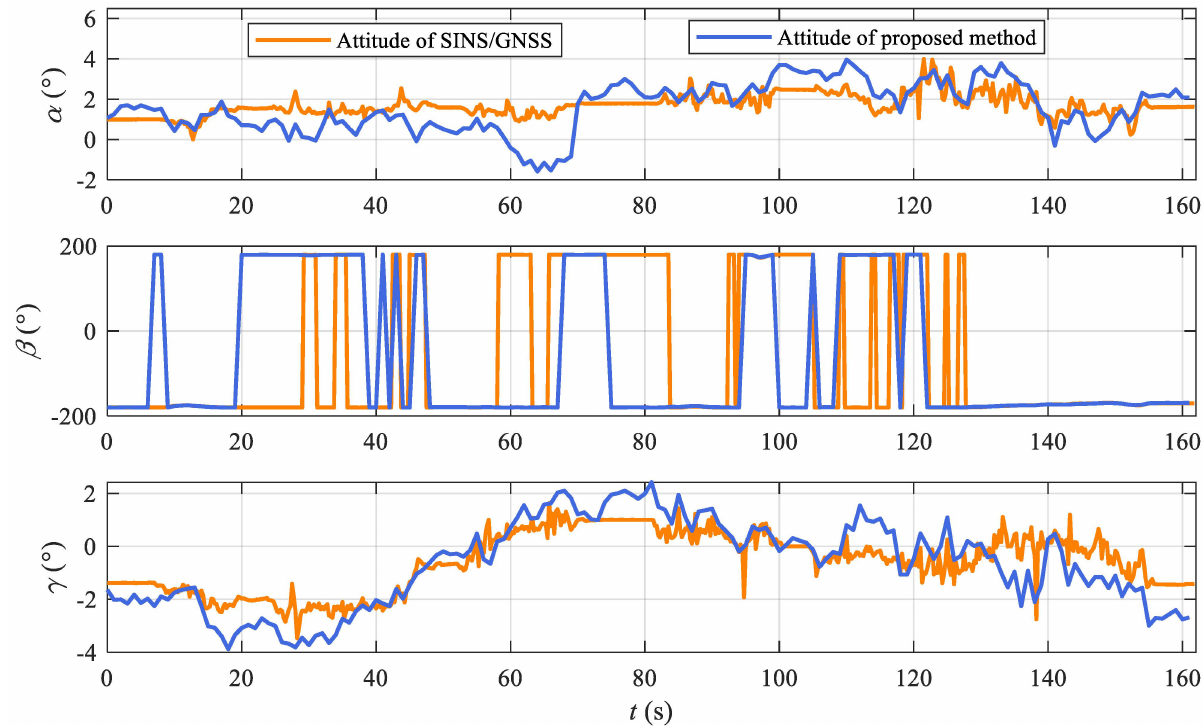
Figure 8. Attitude results of the proposed method and ground